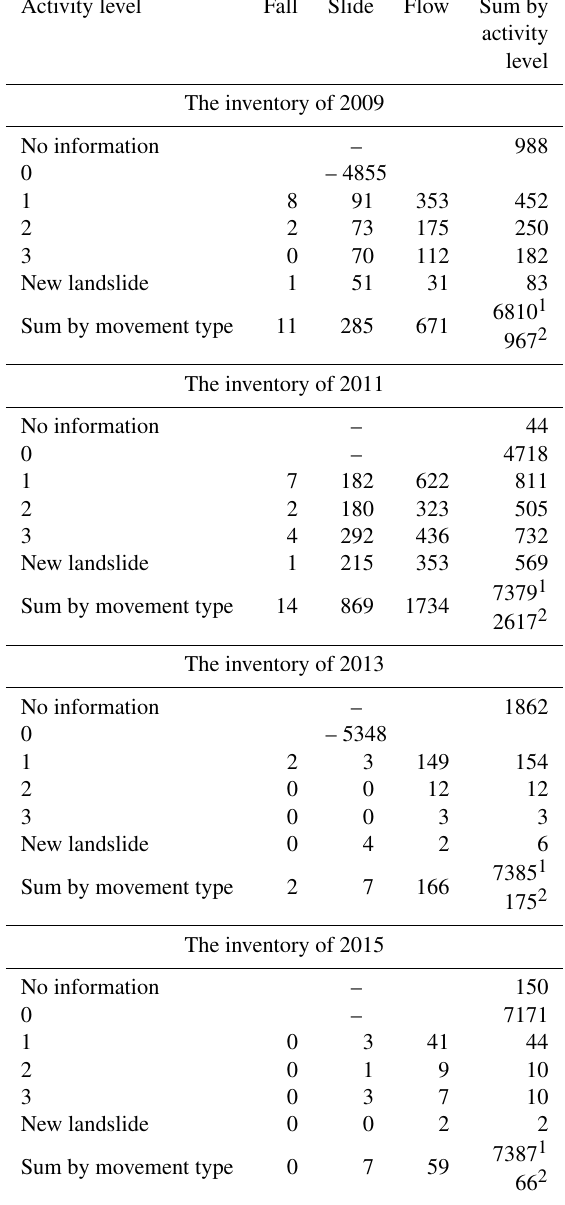
Table 6. Statistics of post-earthquake landslide inventories. 1 The total number of landslides in each inventory including those with- out information (which are either located in cloud-covered areas, or areas outside of the image boundaries). 2 Total number of land- slides in each inventory, excluding those without information and those that are dormant (activity level